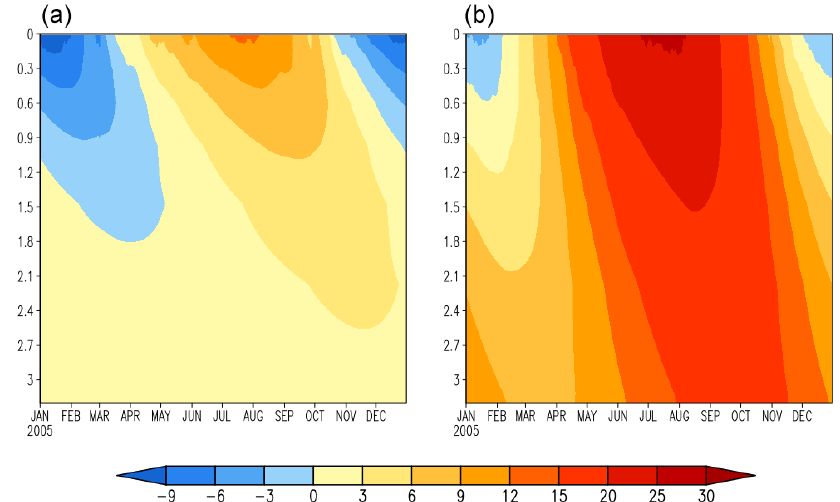
Figure 11. The climatology of simulated daily soil temperature (a) over the TP (14 sites averaged) and (b) NC (16 sites averaged) for 1981–2005 (unit: ◦ C).